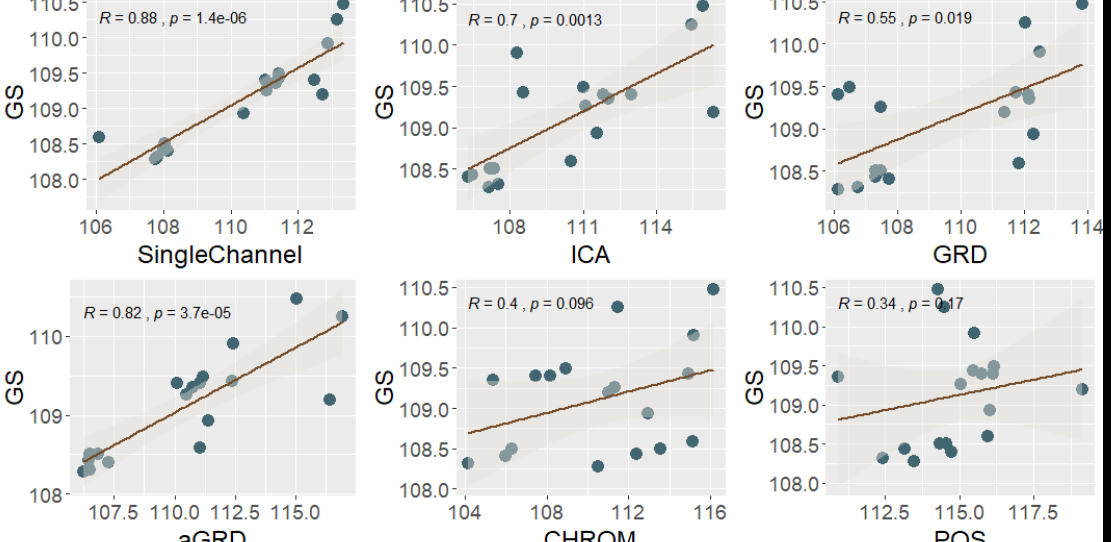
Figure 4. ( a ) The original G channel signal of the anaesthetized pig plotted in time-domain; ( b ) the filtered G channel signal; ( c ) a zoom-in view of the filtered signal; ( d ) time-frequency spectrogram; ( e ) the Welch power spectrum density (PSD) estimate.